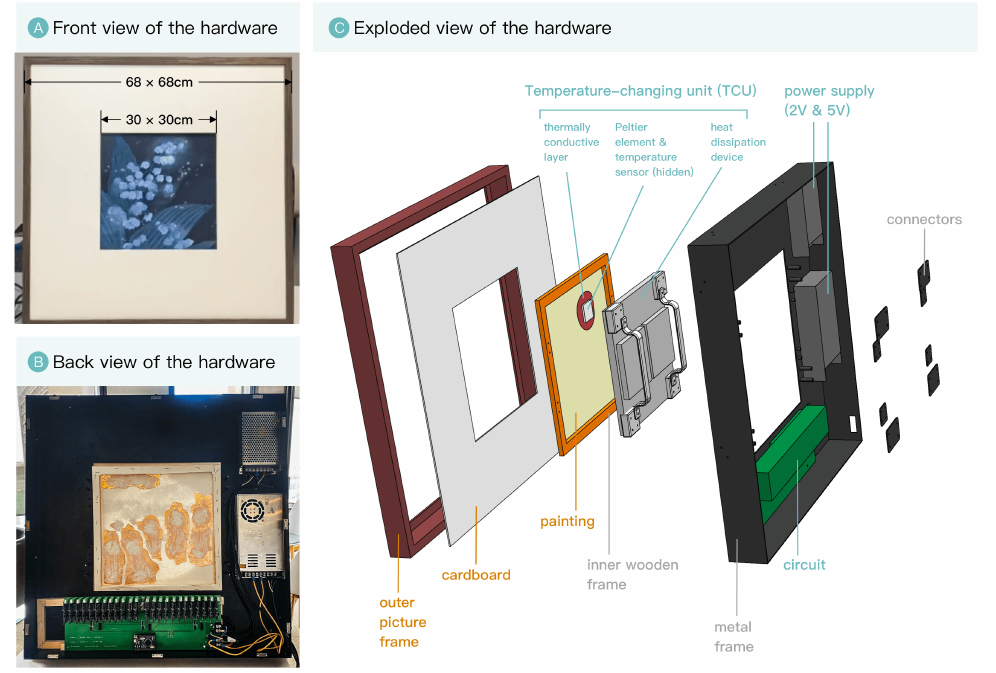
Figure 5. Architecture of the hardware: ( A , B ) photos of the front and the back views of the assembled hardware (The Peltier elements and the heat dissipation device are omitted.); ( C ) the exploded view of the hardware; the three groups of the components are color-coded; ORANGE: common components for picture mount and display, including the outer picture frame, the cardboard and the painting; BLUE: thermal and electronic components for heat control, including the Peltier element, the thermally conductive layer, the temperature sensor, the heat dissipation device, and the circuit and the power supply; GREY: necessary mechanical components for fixing, including the inner wooden frame, the metal frame, and the